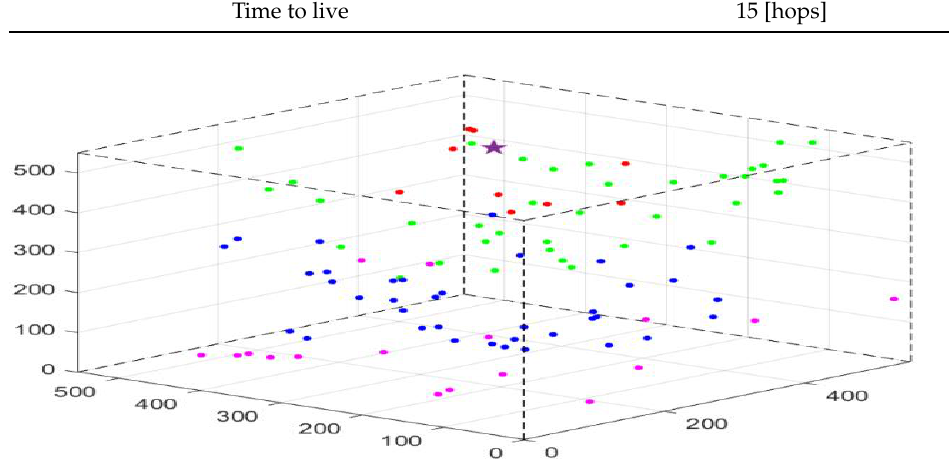
Figure 7. Network Figure 7. Network structure.